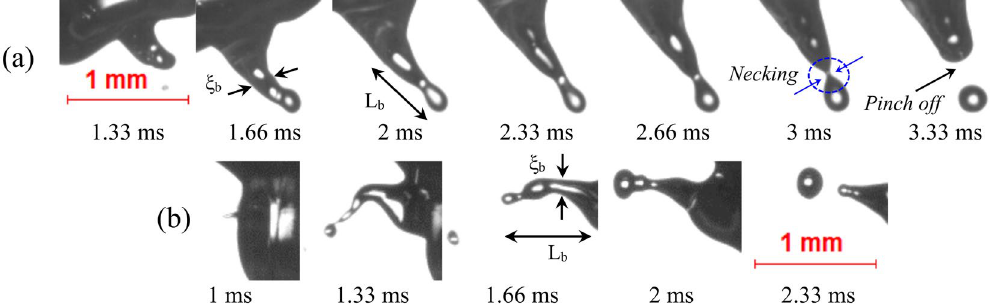
Figure 4. Low momentum thick ligaments with ( a ) tip breakup ( α = 0.5, AR = 3.65) in E30 droplet and ( b ) tip- base breakup ( α = 0.8, AR = 3.93) in B50 droplet. The maximum velocity of the pinched off secondary droplets is O (0.5